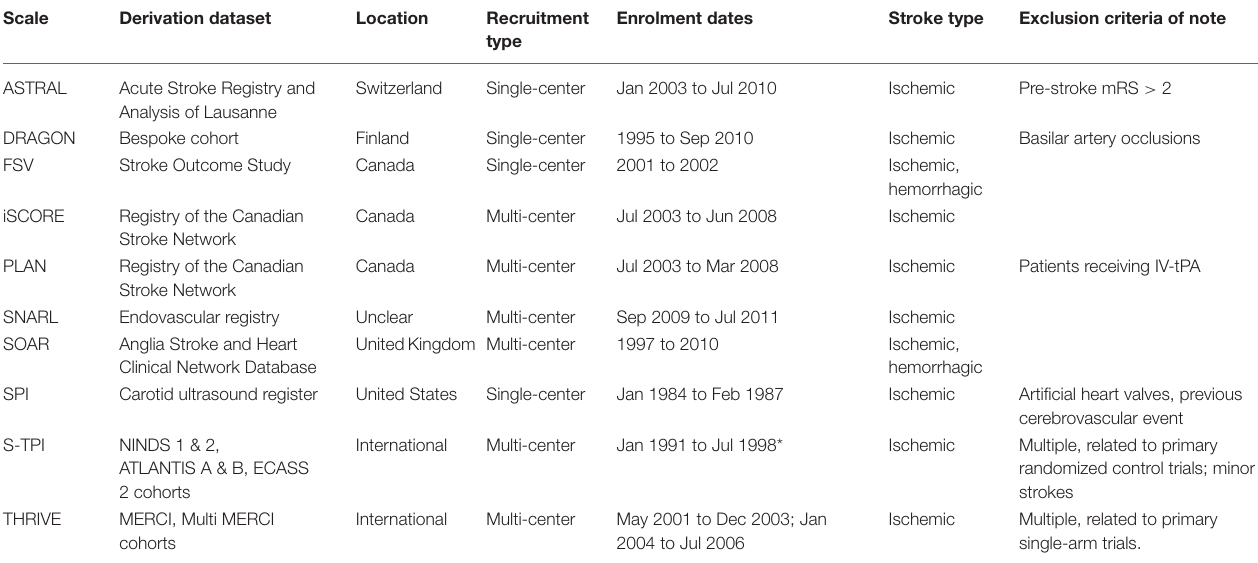
TABLE 1 | Derivation study